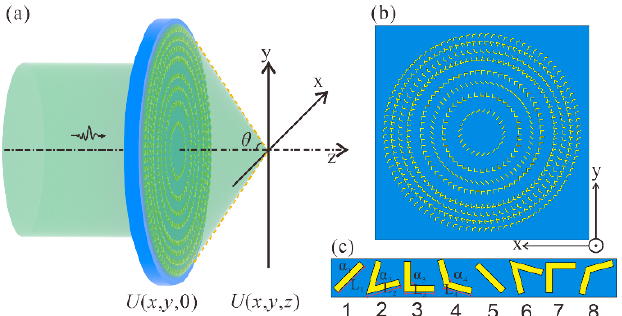
Figure 1. Schematic of the metalens sample with ( a ) perspective and ( b ) front views. The super unit cell of the metalens consists of eight antenna units ( c ) in the order of 1–3–5–7–2–4–6–8. Parameters of units 1–4 are L 1 = 58 μ m, L 2 = 57.9 μ m, L 3 = 47.8 μ m, L 4 = 42.8 μ m and α 1 = 0°, α 2 = 60°, α 3 = 90°, α 4 = 120°, respectively. Units 5–8 were separately obtained by rotating units 1–4 by an angle of 90° clockwise.